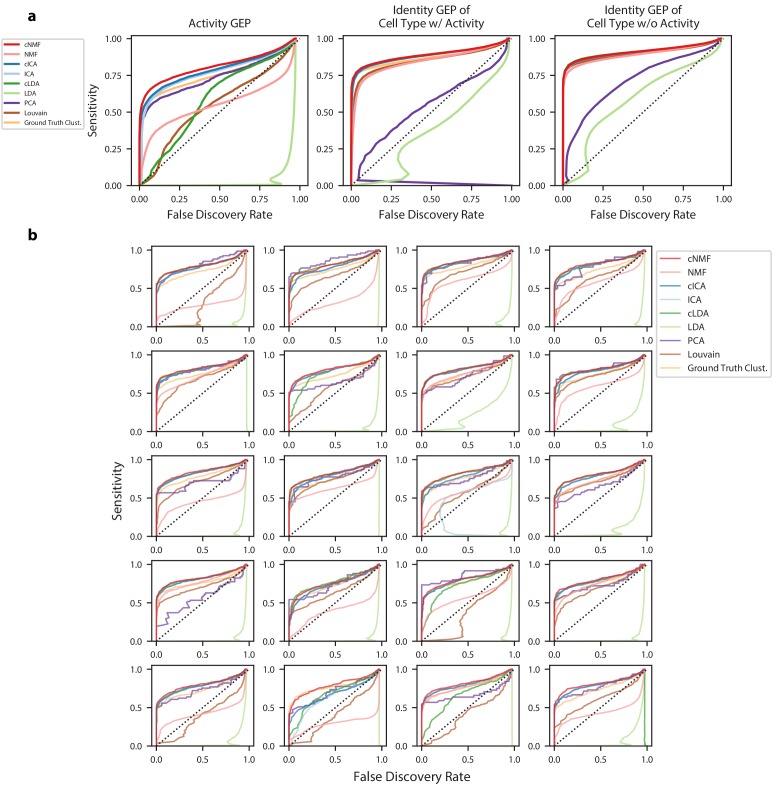
Accuracy of identifying genes in each GEP.(a) Receiver operating characteristics (ROCs) but showing false discovery rate (FDR) on the X-axis against sensitivity on the Y-axis for detection of genes in GEPs. Separate curves are shown for cNMF, cICA, cLDA, NMF, ICA, LDA, ground truth cluster assignment, Louvain clustering, or PCA. These show combined results for all 20 simulations with mean log2 fold-change = 1.00. Sensitivity is calculated considering genes with a differential expression fold-change of >= 2 and FDR is calculated considering genes with no differential expression (fold change = 1) (b) Same as (a) but only showing the results for the activity GEP and plotted separately for each of the 20 simulations at the mean differential expression log2 fold-change of 1.00.